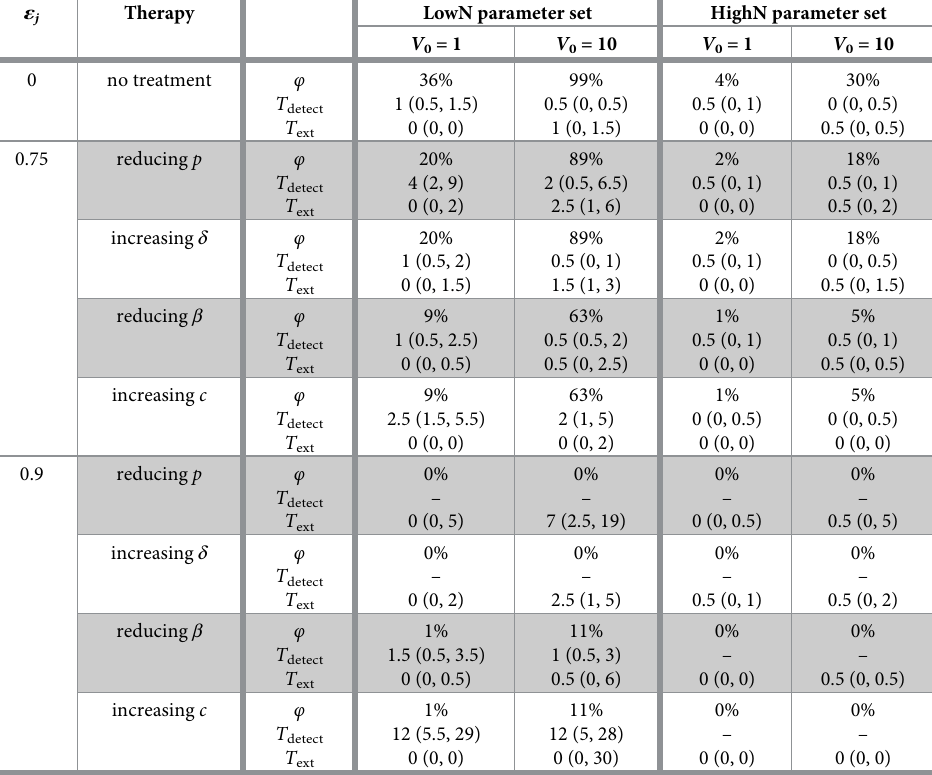
The first value in each cell gives the establishment probability, the second value denotes the median time to detection (days), the numbers in brackets are the 10 and 90-percentiles of the time to detection distribution (days), and the last line gives the median time to extinction (days), conditioned on non-establishment of the infection, with the 10 and 90-percentiles in brackets. The detection threshold is set to 2, 000 virus particles. All times are rounded to half-day values if below 5 days, and to days if above. Missing values, denoted by dashes, are explained by the viral population not establishing. All results are estimated from 100, 000 stochastic simulations for the establishment probability and 10, 000 stochastic trajectories for the extinction and establishment